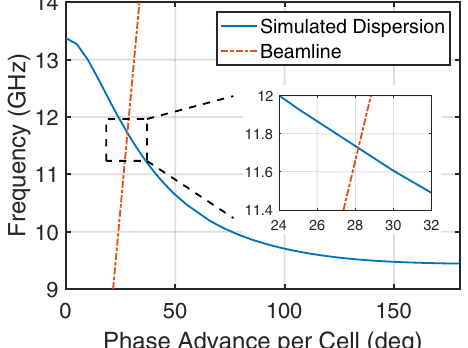
FIG. 3. Simulated dispersion curve for the wagon wheel metamaterial. The rf generated by the interaction with the beam will be at the frequency determined by the intersection of the dispersion curve and the beamline.